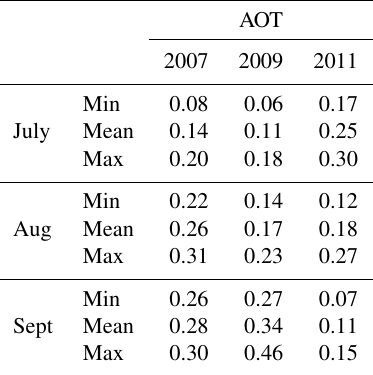
Table 1. A summary of AERONET Level 2.0 sun photometer measurements of daily average aerosol optical thickness (AOT) at 440nm at the University of the Witwatersrand in Johannesburg dur- ing late winter 2007, 2009, and 2011.